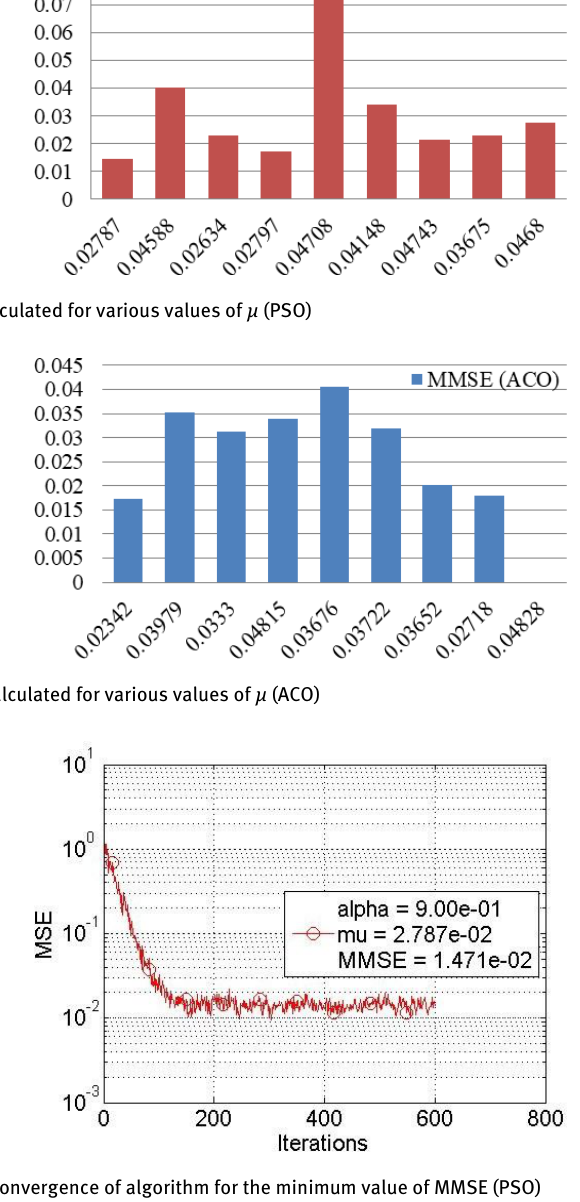
Figure 11: Representing the convergence of algorithm for the minimum value of MMSE